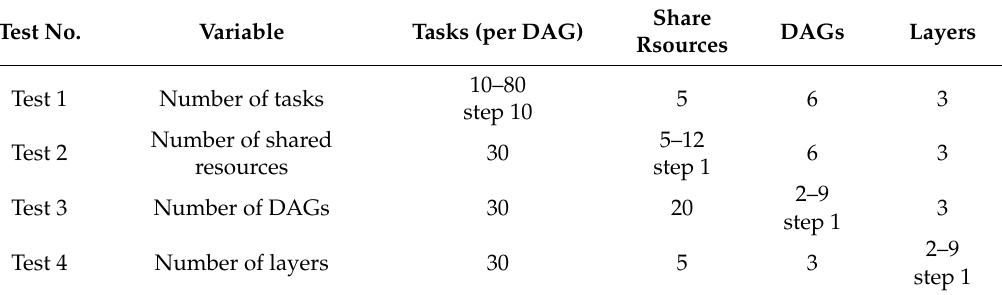
Table 10. Test parameter setting.